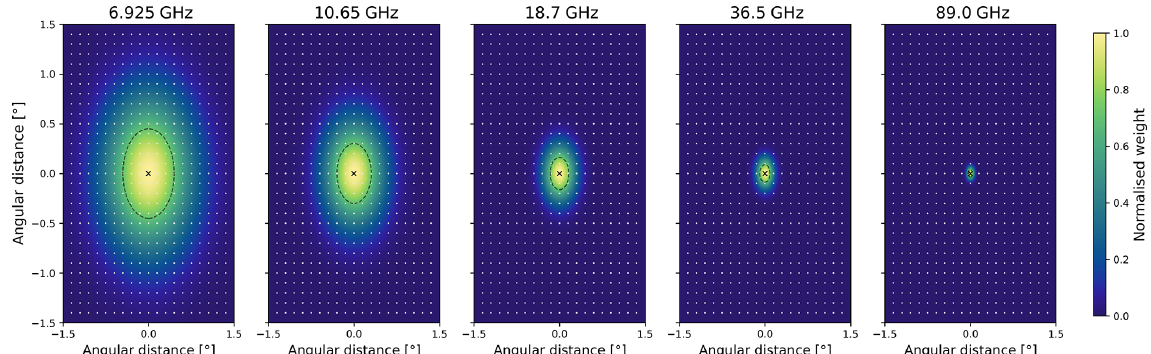
Figure 2. Antenna response in angular space for five modelled AMSR2 frequencies. The response is normalised to have a maximum value of 1.0 at the bore sight, defined by an “x” in each panel, with angular distances defined in reference to the bore sight. The HPBW is shown by a dashed line in each panel, as defined in Table 1. The aspect ratio of the plots approximates the perspective if viewed at a 55 ◦ incidence angle on the Earth’s surface, hence the elliptical shape. Grey dots signify a typical angular grid spacing for pencil beam calculations.